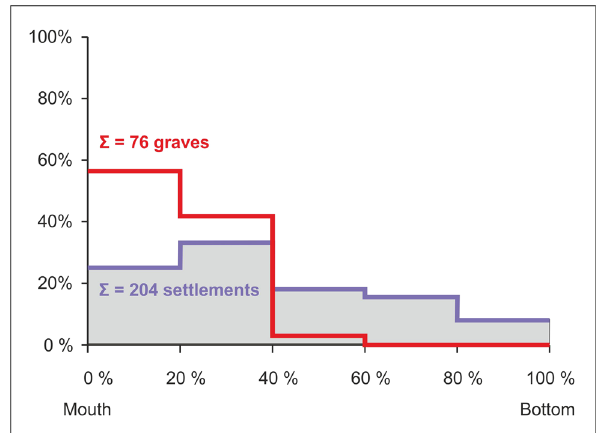
Figure 1: The distance of Late Mesolithic graves ( red line ) and settlements ( blue line ) associated with inlets and fjords from the mouth of the water bodies on which they are located, shown in intervals of 20% of the total length of the latter. While the graves follow the pattern prescribed by the fi shing - site model, the distribution of the settlements is quite di ff erent. After Grøn ( 2020 )